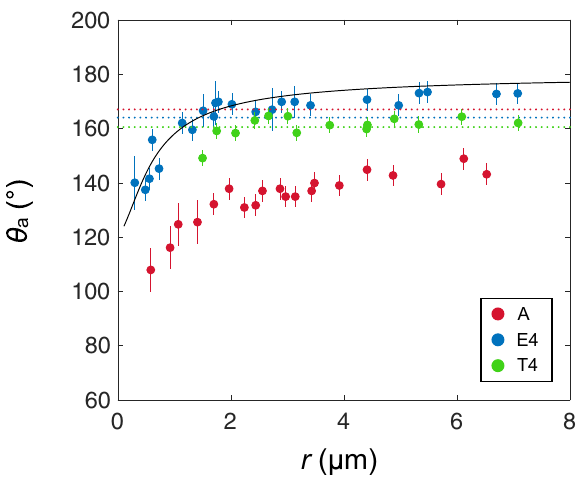
Fig. 3 Contact angle of condensing microdroplets on nanostructures. Advancing contact angle θ a measured by ESEM imaging as a function of the droplet radius r for materials A (nanocylinders, red dots), T4 (truncated nanocones, green dots) and E4 (nanocones, blue dots). In all cases, θ a increases and saturates with r , but angles are systematically higher by about 20° and 30° on T4 and E4 than on A. Angles on A increase from 110° ± 5° to 140° ± 3° as r varies from 0.6 to 6 µ m, on T4 from 150° ± 2° to 163° ± 2° as r varies from 2 to 7 µ m, and on E4 from 140° ± 7° to 171° ± 3° as r varies from 0.3 to 7 µ m. The solid line is the model for nanocones described in the text and in the Methods section (Eqs. 1 and 2). We also report with dotted lines the contact angles obtained for millimetric water drops on A, T4 and E4, θ a = 167° ± 3°, 160° ± 2° and 164° ± 3°, respectively. Interestingly, these angles are much larger for A and slightly smaller for T4 and E4 than the saturation value at microscale. Error bars represent standard